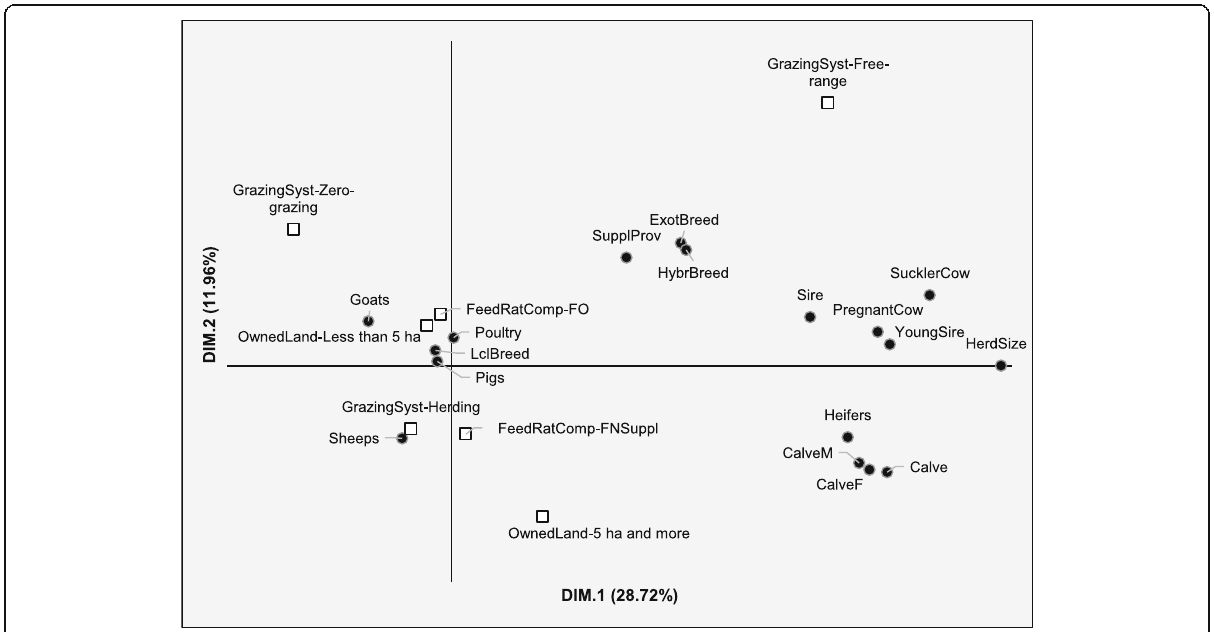
Fig. 3 Projection of modalities (squares) and quantitative variables (dots) in the main plane (Dim.1 – Dim.2)